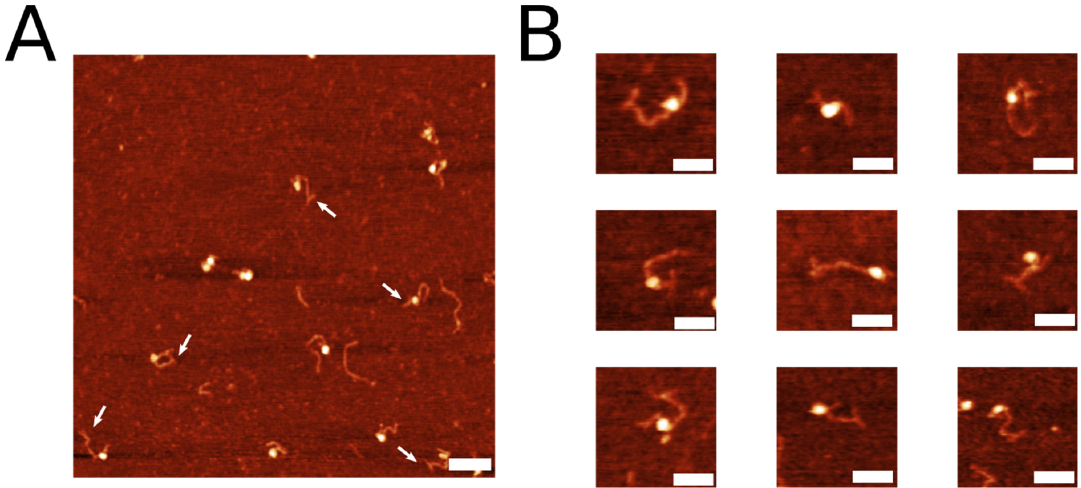
Figure 5. AFM images of nucleosomes assembled on labeled DNA. ( A ) A representative frame with images of assembled nucleosomes. White arrows indicate 3WJ labels. Scale bar indicates 100 nm. ( B ) Selected snapshots of nucleosomes with label present. Scale bar indicates 50 nm.